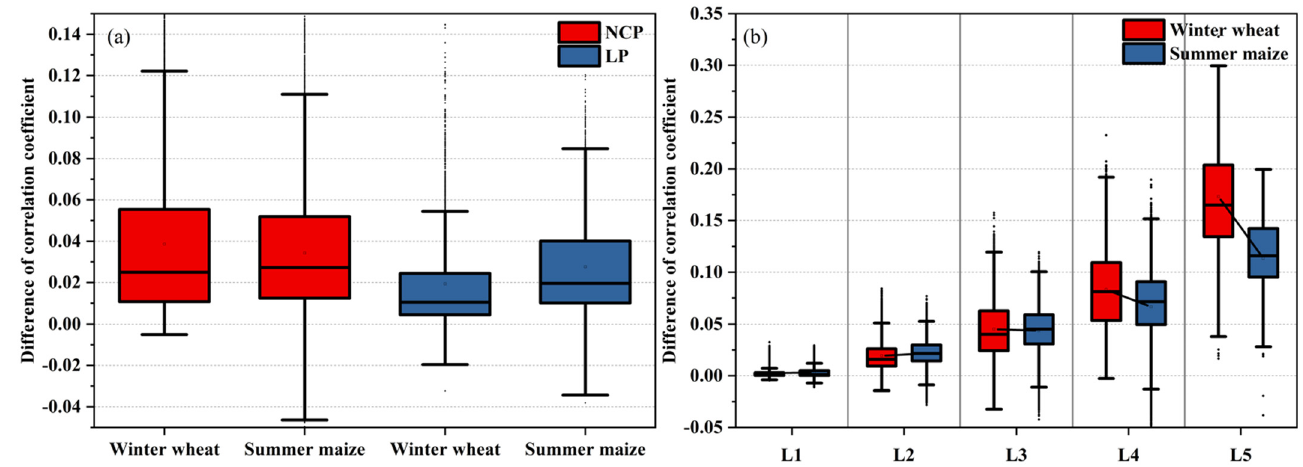
Figure 8. The correlation coefficient difference values of winter wheat and summer maize in differ- ent major crop-producing areas ( a ) at different irrigation levels ( b ). The irrigation levels of L1, L2, L3, L4 and L5 represented irrigation levels of 0–20%, 20–40%, 40–60%, 60–80%, and 80–99%, respec-